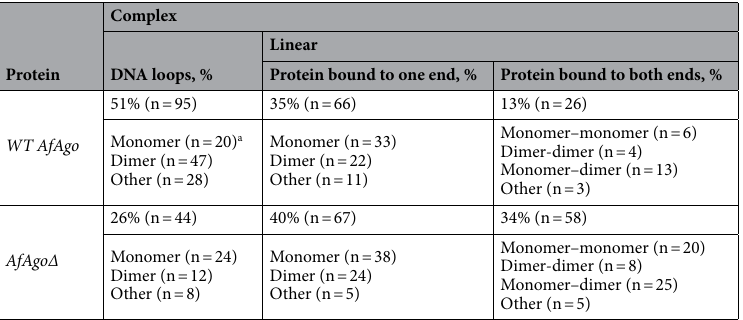
Table 1. AfAgo-DNA complexes observed by AFM (see Supplementary Fig. S4). a The calculated volume of WT AfAgo (50.8 kDa) and AfAgoΔ (49.9 kDa) proteins is approx. 100 nm 3 . Thus, the measured